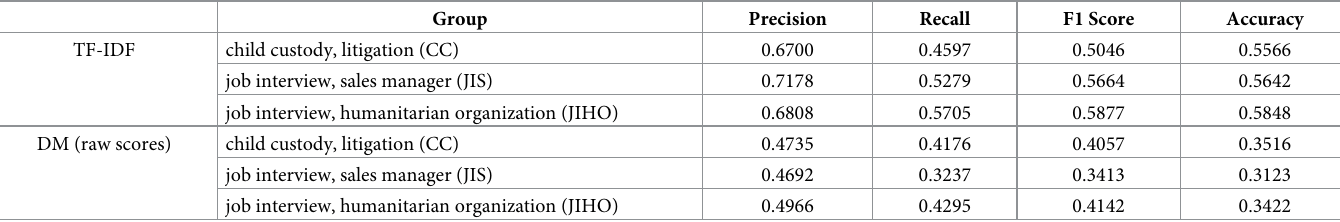
Table 7. Performance evaluation.